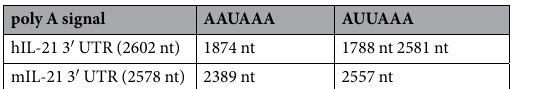
Table 1. Polyadenylation (poly A) sites in the 3 ′ UTR of human or mouse